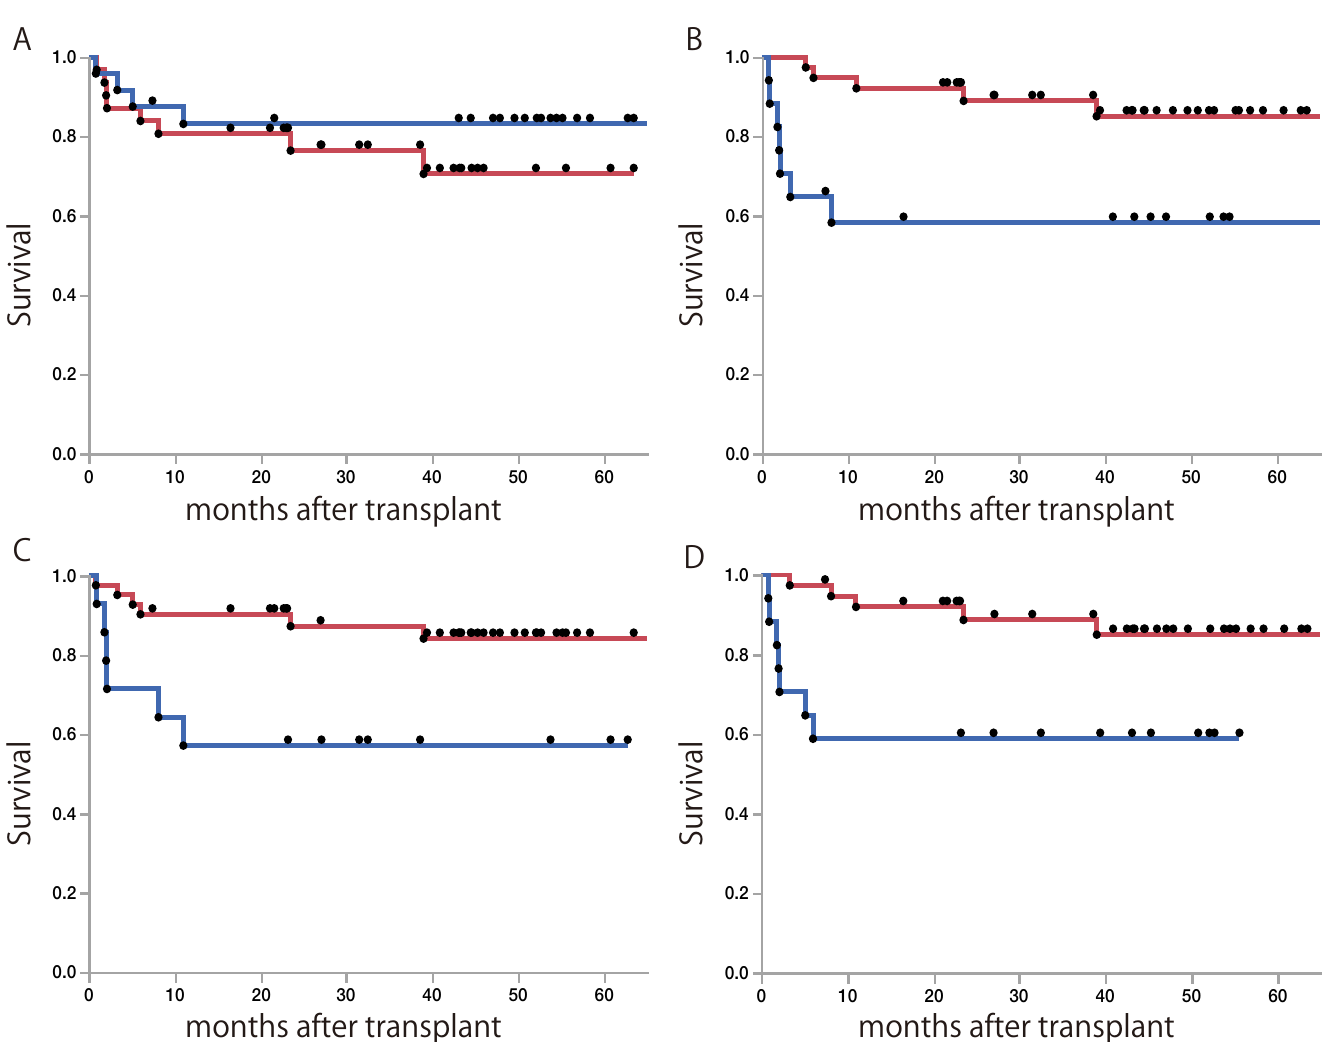
Fig 7. Survival curves of recipients after LDLT. (A) Comparison of the cumulative survival curves stratified with B-RTL ( < 4.6 x 10 5 rfu, red line, and � 4.6 x 10 5 rfu, blue line). (B) Comparison of the cumulative survival curves stratified with L-RTL ( < 2.7 x 10 5 rfu, red line, and � 2.7 x 10 5 rfu, blue line). (C) Comparison of the cumulative survival curves stratified with donor age ( < 45 years old, red line, vs � 45 years old, blue line). (D) Comparison of the cumulative survival curves stratified with MELD score ( < 18, red line, and � 18, blue line).